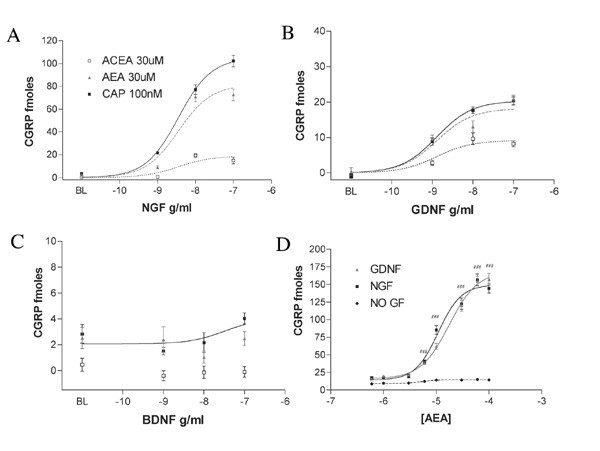
The effect of growth factor treatment on AEA- and ACEA-evoked CGRP release. TG neurons were grown in the presence of the indicated concentrations of NGF (panel A), GDNF (panel B) or BDNF (panel C) for five days and then exposed to 100 nM CAP, 30 μM AEA or 30 μM ACEA for 10 min, and the released CGRP was quantified (n = 12). Panel D, TG neurons were grown in the absence of growth factors or in the presence of 100 ng/ml NGF or GDNF for 5 days and exposed to the indicated concentrations of AEA (molar, log units) to assess CGRP release (### p < 0.001; GDNF and NGF vs. no growth factor; two-way ANOVA, Bonferroni post-test, n = 6).